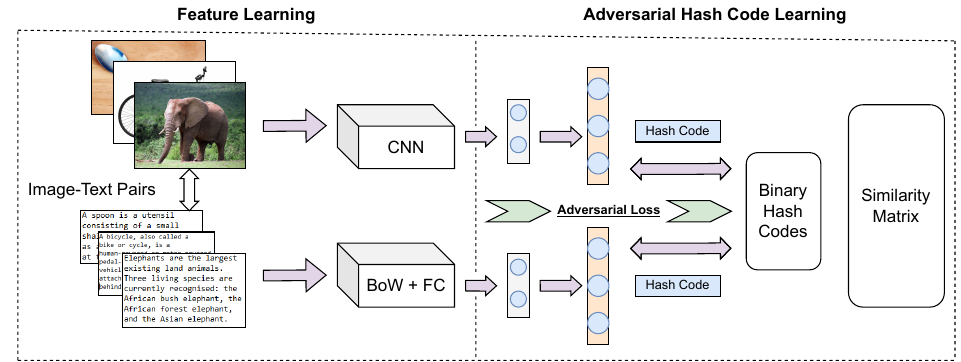
Figure 3. Simplified workflow of adversarial-based CMH methods depicting approaches used by methods such as Deep Adversarial Discrete Hashing (DADH) [12] and Adversary Guided Asym- metric Hashing (AGAH) [10] (CNN: Convolutional Neural Network, BOW: bag of words, FC: Fully Connected